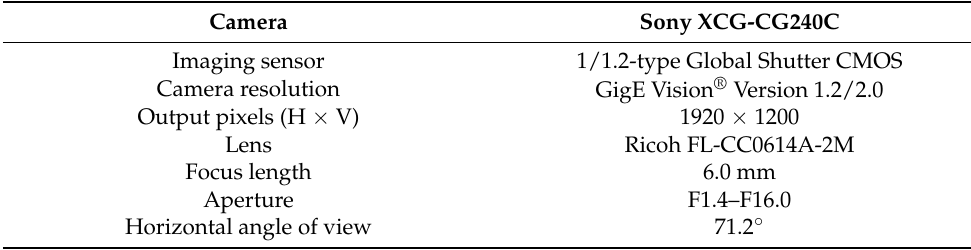
Table 1. Parameters of the camera and lens.